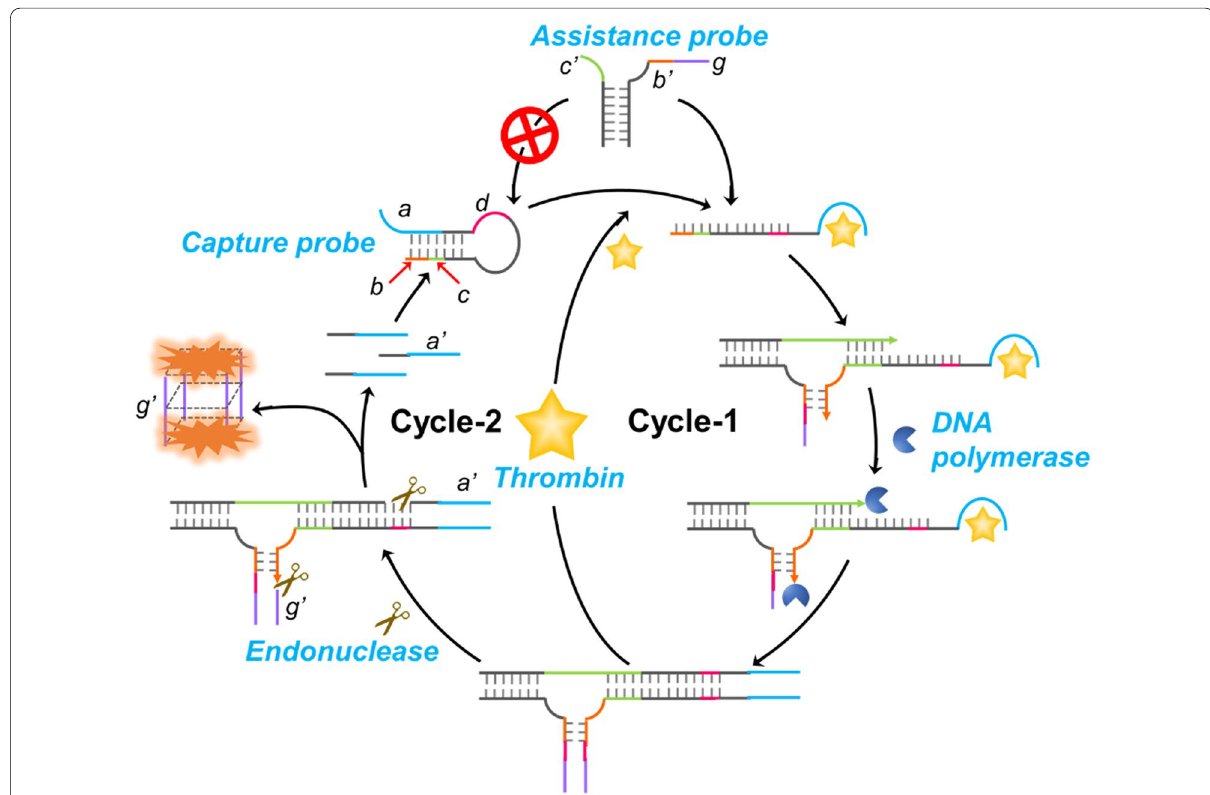
Fig. 1 The working mechanism of the constructed approach